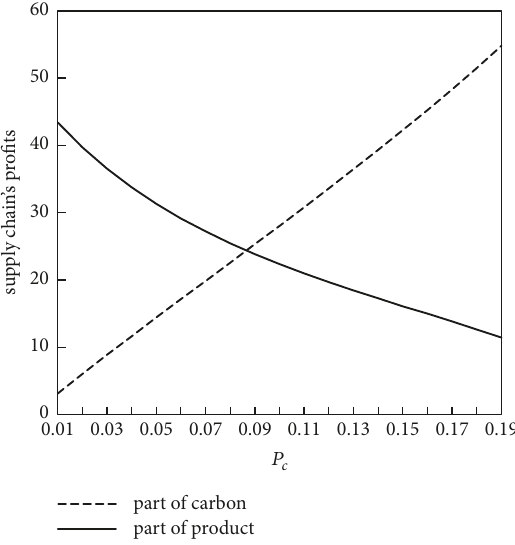
Figure 6: Profit structure under different carbon prices in the centralized